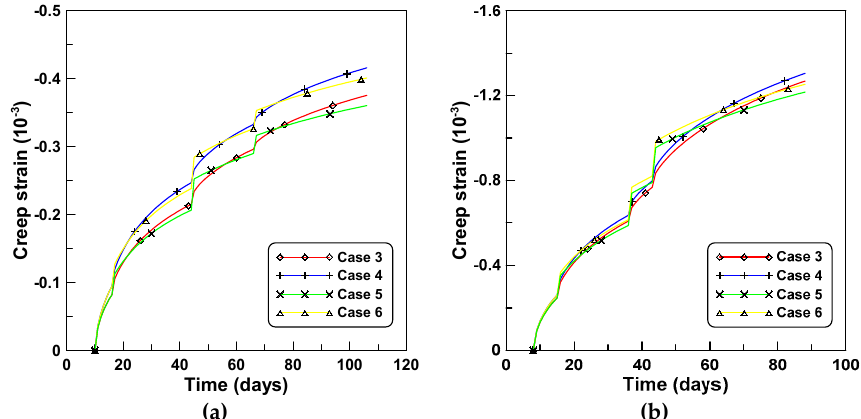
Figure 5. Creep strains obtained by different creep models under stepwise loads: ( a ) test series A and ( b ) test series B.